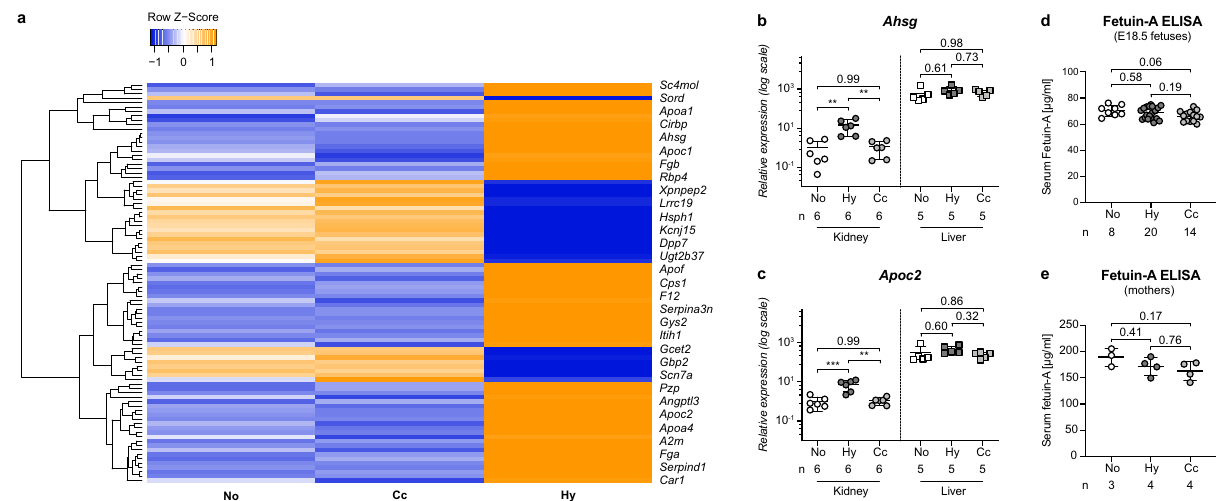
Fig. 2 Hypoxia-induced gene expression in the kidney. a Hierarchical clustering of cDNA microarray data comparing the renal gene expression pro fi les of hypoxic (Hy), normoxic (No), and caloric control (Cc) group E18.5 fetuses ( N = 3 per experimental condition). Orange indicates induction, blue repression. Clustering was performed for genes with at least 1.3-fold regulation of hypoxic vs. both normoxic controls; 1way ANOVA; P < 0.05. b , c Relative mRNA values of Ahsg ( b ) or Apoc2 ( c ) in E18.5 kidneys (circles) or liver samples (squares) shown as mean ± SEM. N = fetal organs. Kidney and liver samples are analyzed separately. Note the logarithmic scale on the y -axis. d , e Serum fetuin-A levels assessed by ELISA are presented as mean and ± SEM. N = serum samples. No signi fi cant changes were observed among normoxic (No), hypoxic (Hy), or caloric control (Cc) E18.5 fetuses ( d ), nor for their mothers ( e ). Ordinary one-way ANOVA with Tukey ’ s multiple comparison test ( b – e ). Individual P -values are denoted above the comparison lines ( b – e ). (*** P < 0.001; ** P < 0.01). Source data are provided as a Source Data fi